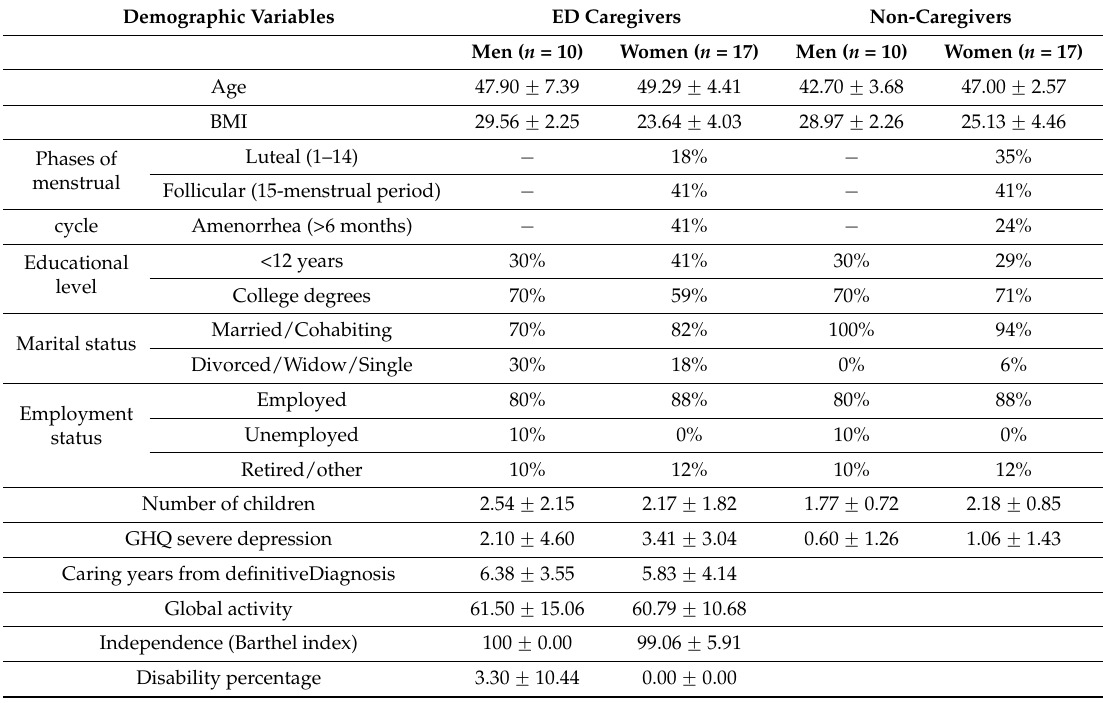
Table 1. Mean ˘ SD of age, BMI and demographic variables for women caregivers and non-caregivers. Demographic